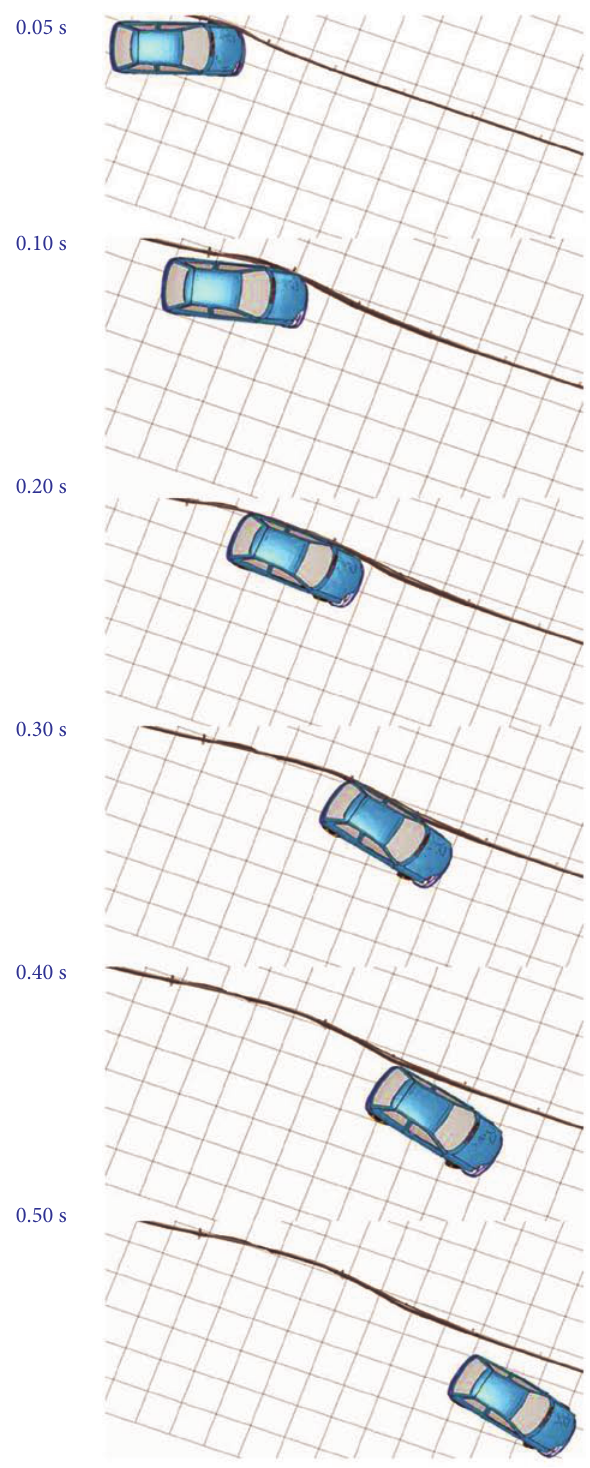
Fig. 5. Top view of the impact of vehicle and safety barrier: impact angle 20°, velocity 100 The downward back stretch was simulated in